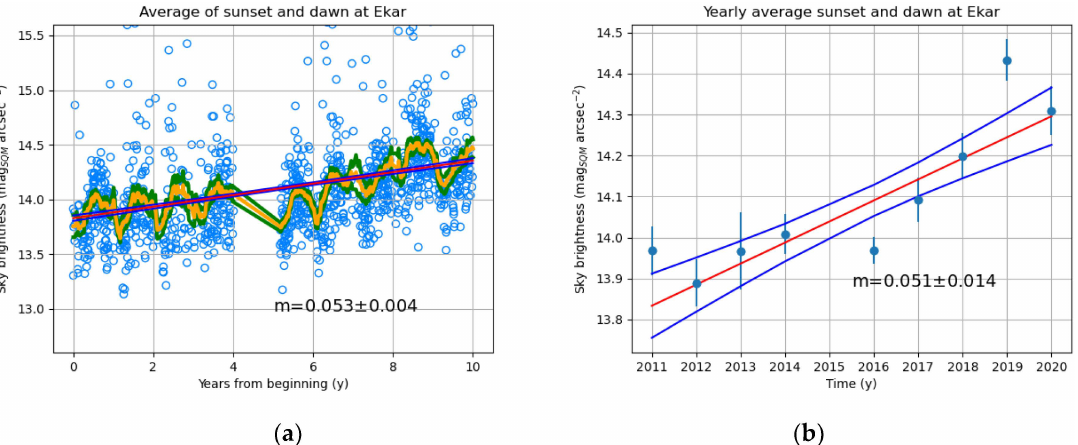
Figure 10. Trends of the sky brightness at zenith at Ekar: average values at sunset and dawn ( a ) with their moving average (yellow curve) and aside the green curves accounting for one standard deviation ( a ) and the annual average values ( b ) when the Sun altitude is around − 6.5 ◦ , the red line is the linear fitting and the blue curves account for the uncertainty on the fitting